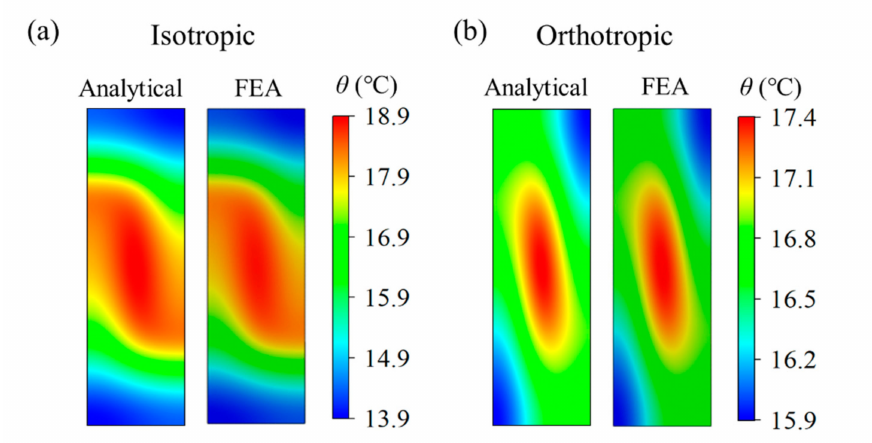
Figure 3. Comparison of the analytical and FEA temperature field on the bottom surface of a quarter of the unit cell based on ( a ) the isotropic and ( b ) orthotropic